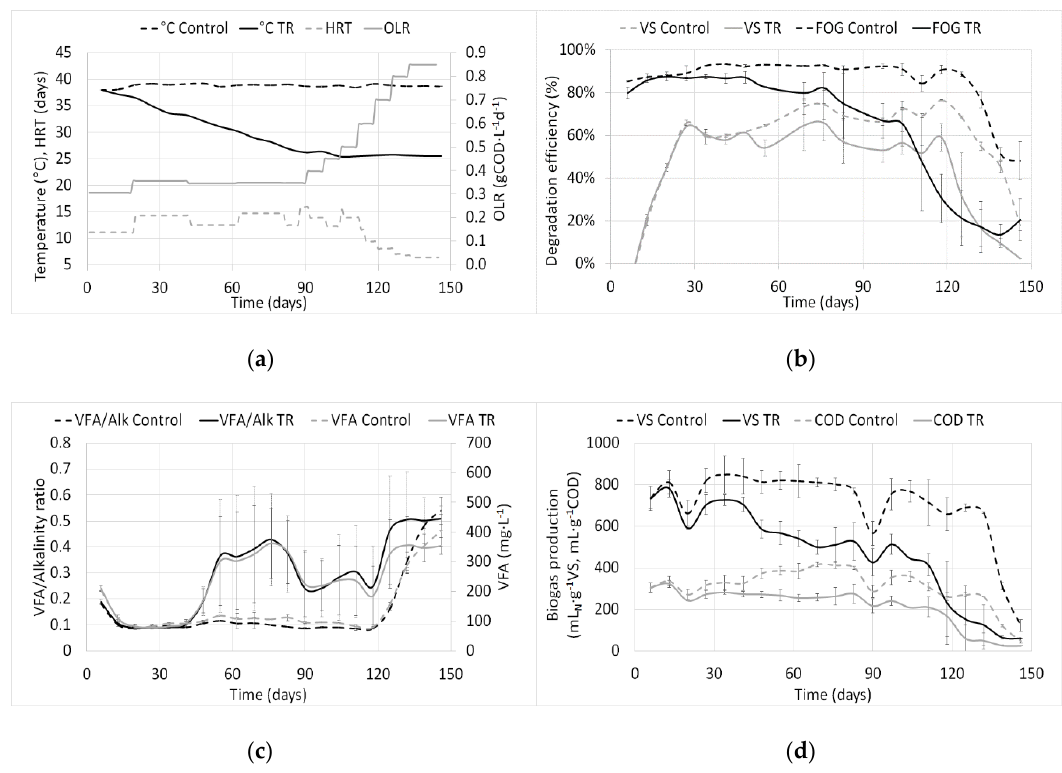
Figure 3. ( a ) Temperature reduction (TR), hydraulic retention times and incremental organic loading rates in experimental reactors [27]; ( b ) Solids and FOG degradation e ffi ciency in response to temperature reduction and organic loading increase [27]; ( c ) E ff ect of temperature reduction and OLR increase on process stability [27] and; ( d ) E ff ect of temperature reduction and organic loading on biogas production per unit of vs. and COD [27]. Error bars represent one standard deviation from the